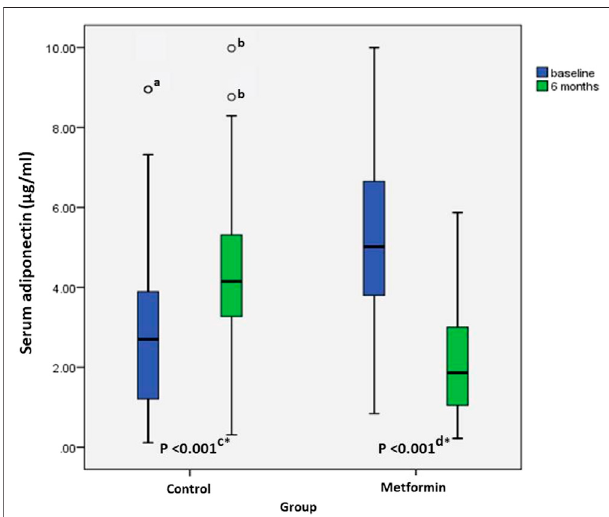
FIGURE 2 | Boxplot of serum adiponectin levels of control group ( n (cid:1) 30), and metformin group ( n (cid:1) 30) at baseline, and after 6 months. Medians (ranges)ofserumadiponectinlevelsincontrolgroupwere2.7(0.11 – 8.95)and 4.15 (0.31 – 9.98) at baseline and after 6 months respectively compared to 5.01 (0.84 – 10) and 1.86 (0.22 – 5.87) in metformin group at baseline and after 6 months respectively. a: Outlier in control group at baseline. b: Outliers in control group after 6 months. c: Comparison between baseline and after 6 months levels of serum adiponectin in the control group using Wilcoxon Signed Rank test, d: Comparison between baseline and after 6-months levels of serum adiponectin in metformin group using Wilcoxon Signed Rank test, *: Indicates statistical signi fi cance.